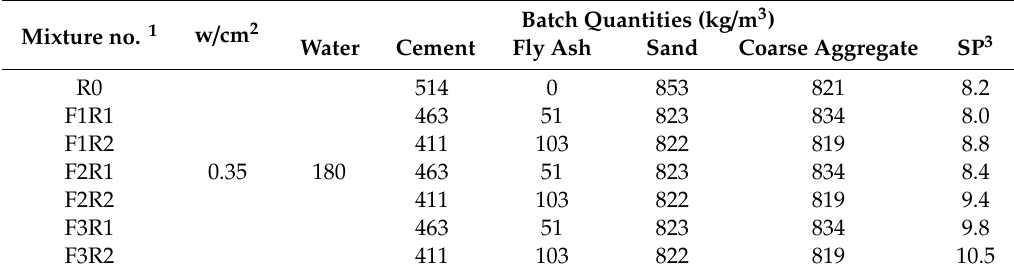
Table 2. Mixture proportions of